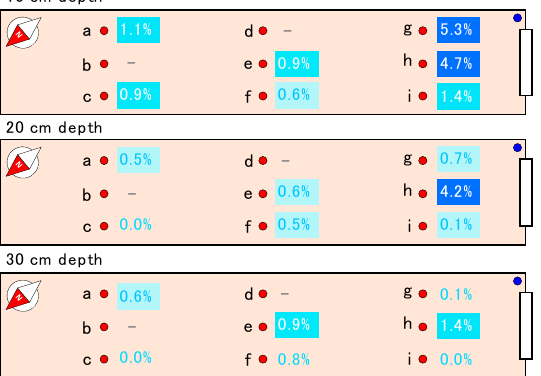
September 2015. 29 September